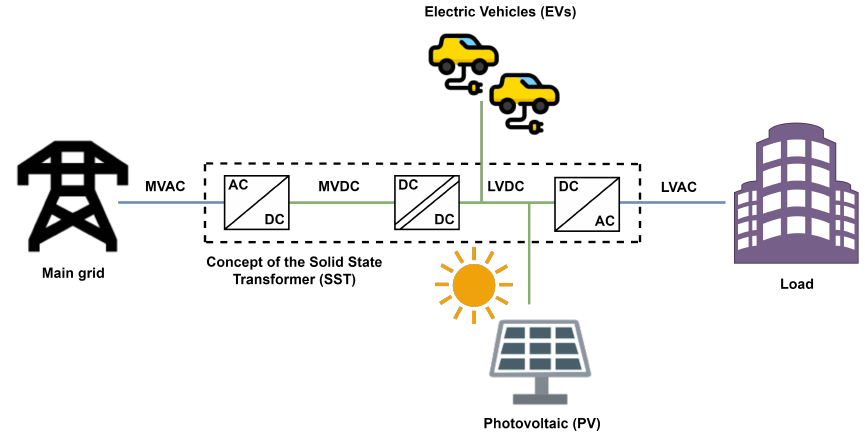
Figure 1. Basic concept of the SST.